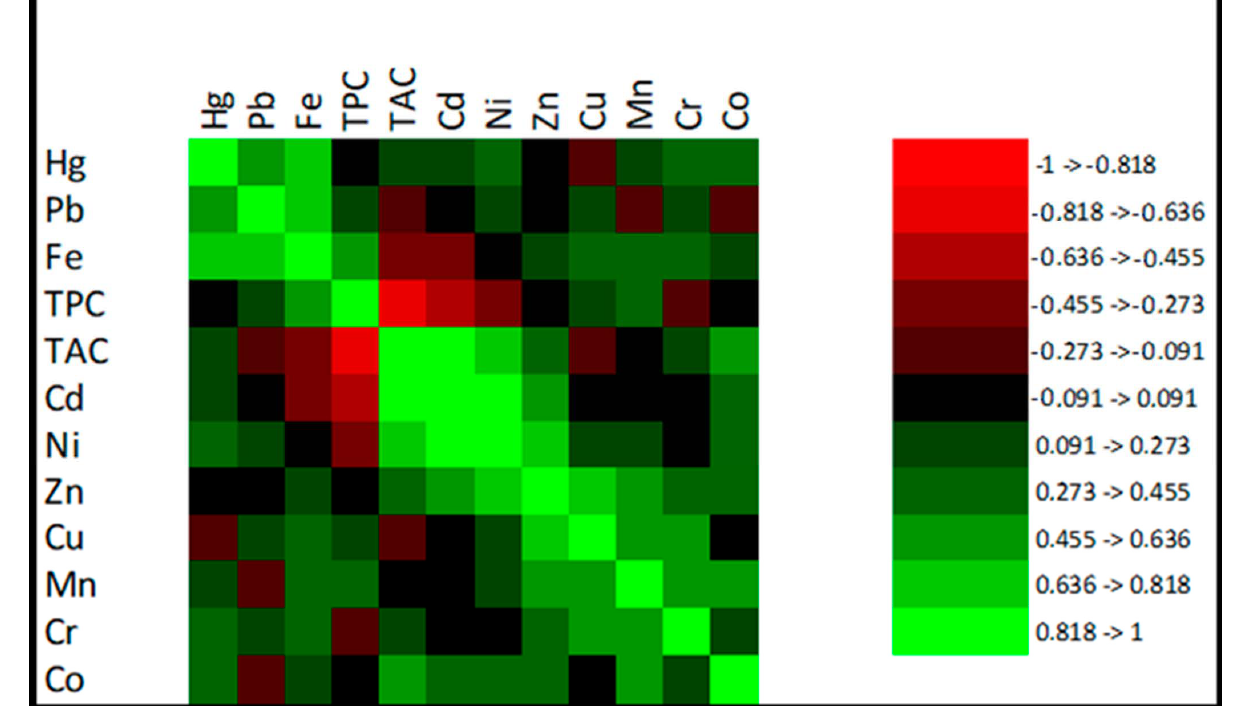
Figure 3. Correlation map for heavy metals, TAC, and TPC in tea samples. Figure 3 showed that Cd had a negative correlation ( − 0.636 to − 0.455) with Total Polyphenol Content. The research focused on antioxidant capacity, metal contents, and their